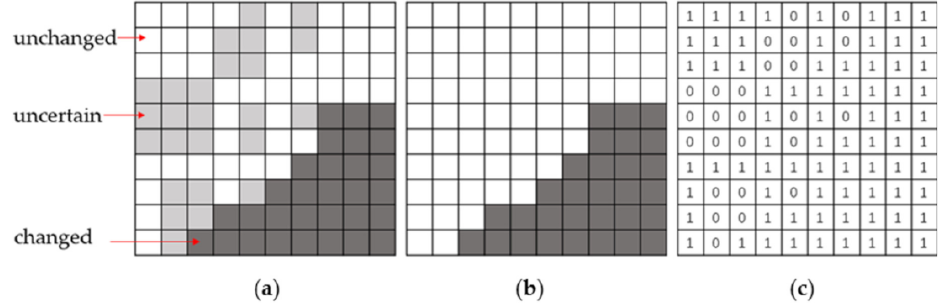
Figure 3. ( a ) Pre-classification result ( L n,pre ). Pixels in white and black colors are selected labels. ( b ) The final label with a regular shape. ( c ) The mask. Pixels belonging to the changed and unchanged categories in ( a ) are weighted to be 1. Pixels belonging to the uncertain category are weighted to be 0.